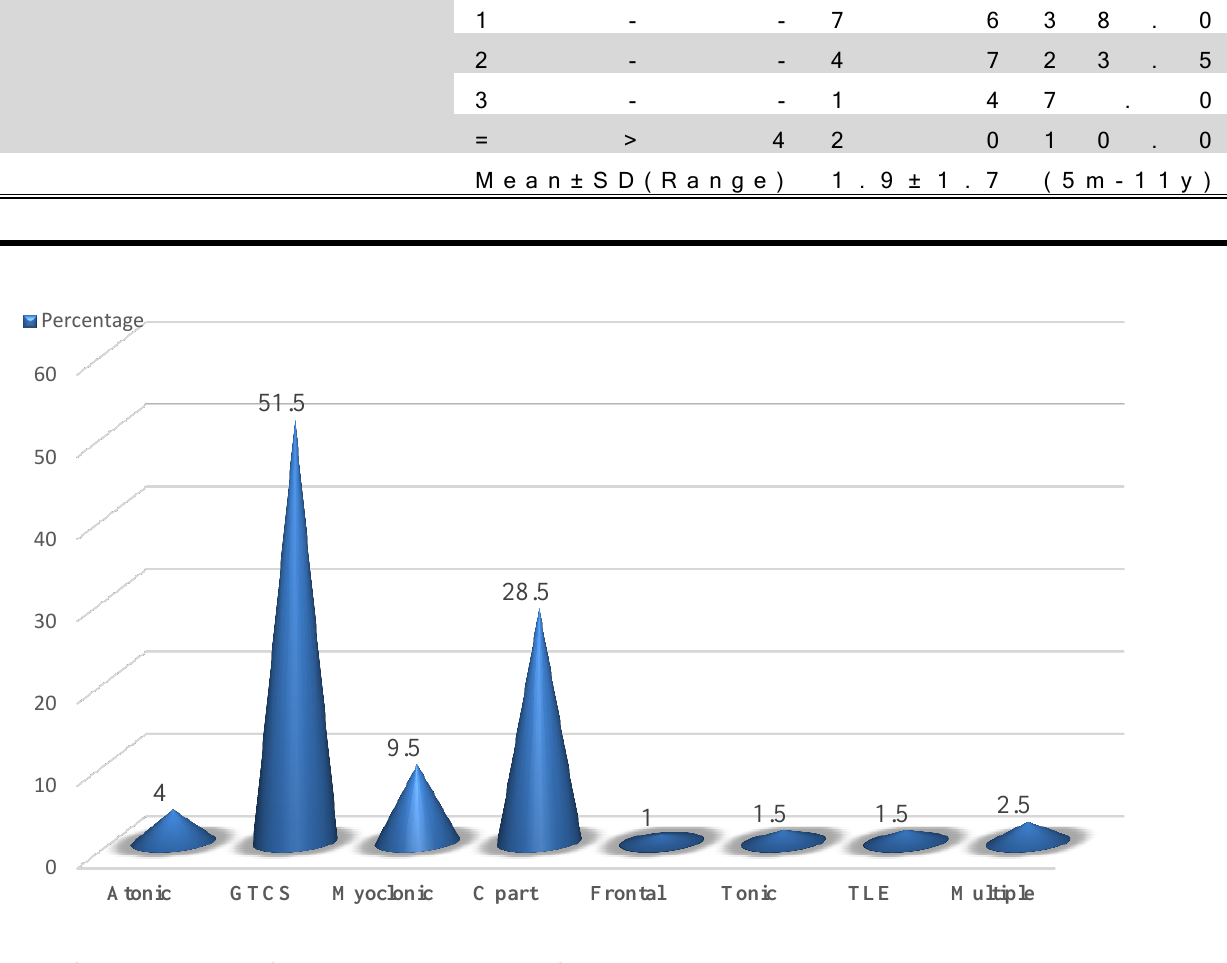
Figure 2: The distribution of patients according to type of seizure Table 6: The distribution of patients according to EEG findings E E G